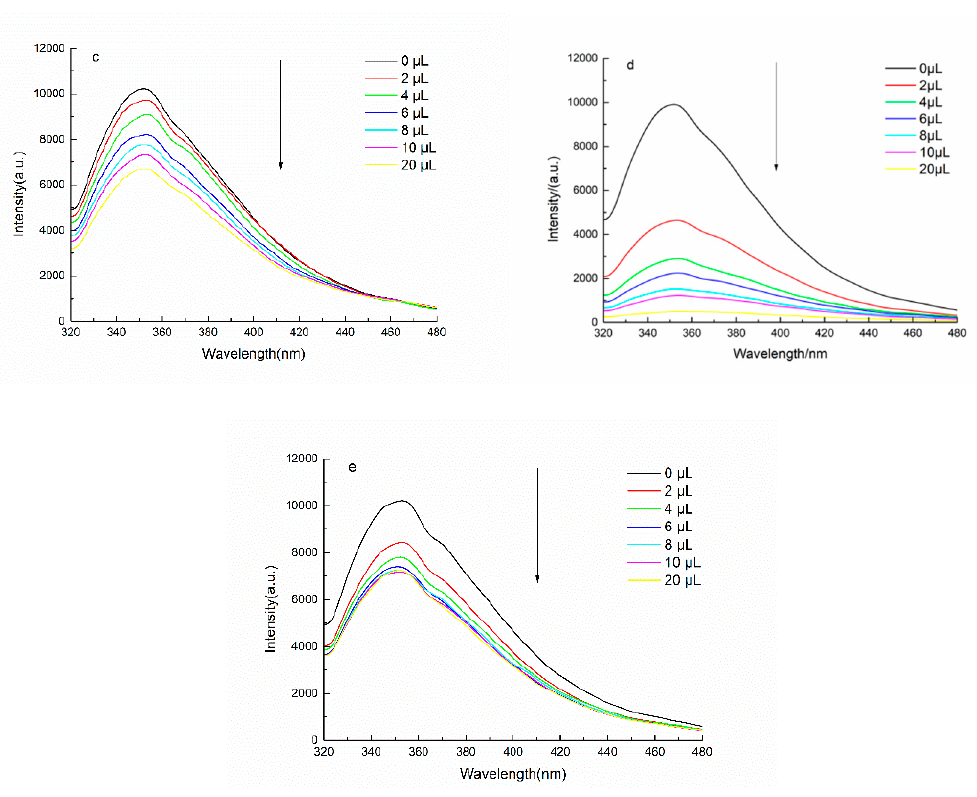
Figure 12. Effect of ( a ) Cu 2+ , ( b ) Ba 2+ , ( c ) Al 3+ , ( d ) Fe 3+ and ( e ) Ni 2+ ions on fluorescence intensity of LOPC.